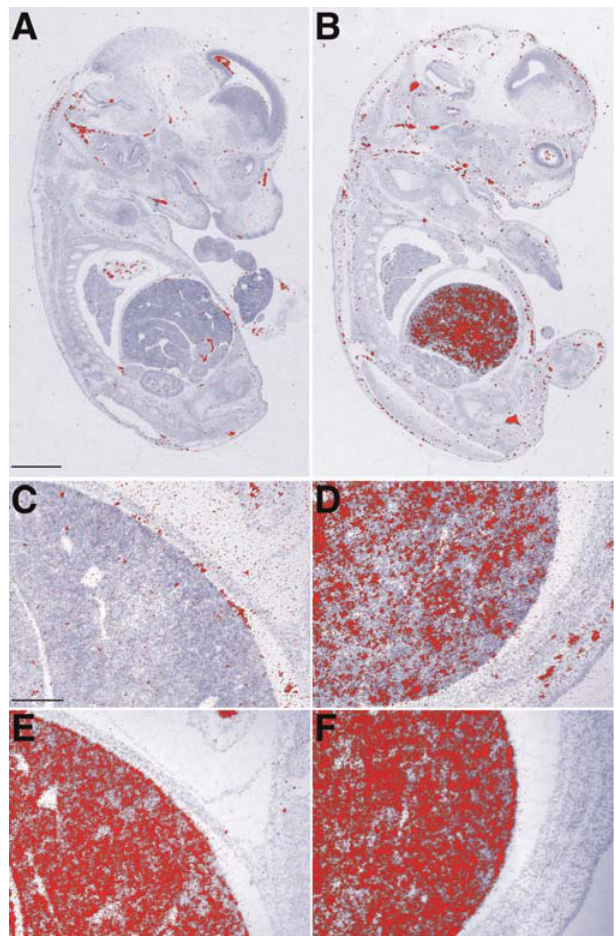
Figure 5. In Situ Hybridization of e y and b maj/min transcripts in WT and p 100H Mutant Mice at 14.5 dpc Expression of e y globin (A–D) and b globin (E and F) in sagittal sections of 14.5-dpc fetuses is shown in pseudocolor (red). (A) WT fetus. (B) p 100H Homozygous mutant fetus. (C and D) Inset boxes are shown. Prominent expression of e y globin is only detected in the liver of mutant mice. (E and F) In contrast, both WT and mutant mouse livers express adult b maj/min, respectively. No signals were detected above background using sense probes (unpublished data). The size bars represent 1 mm for (A) and (B); 100 l m for